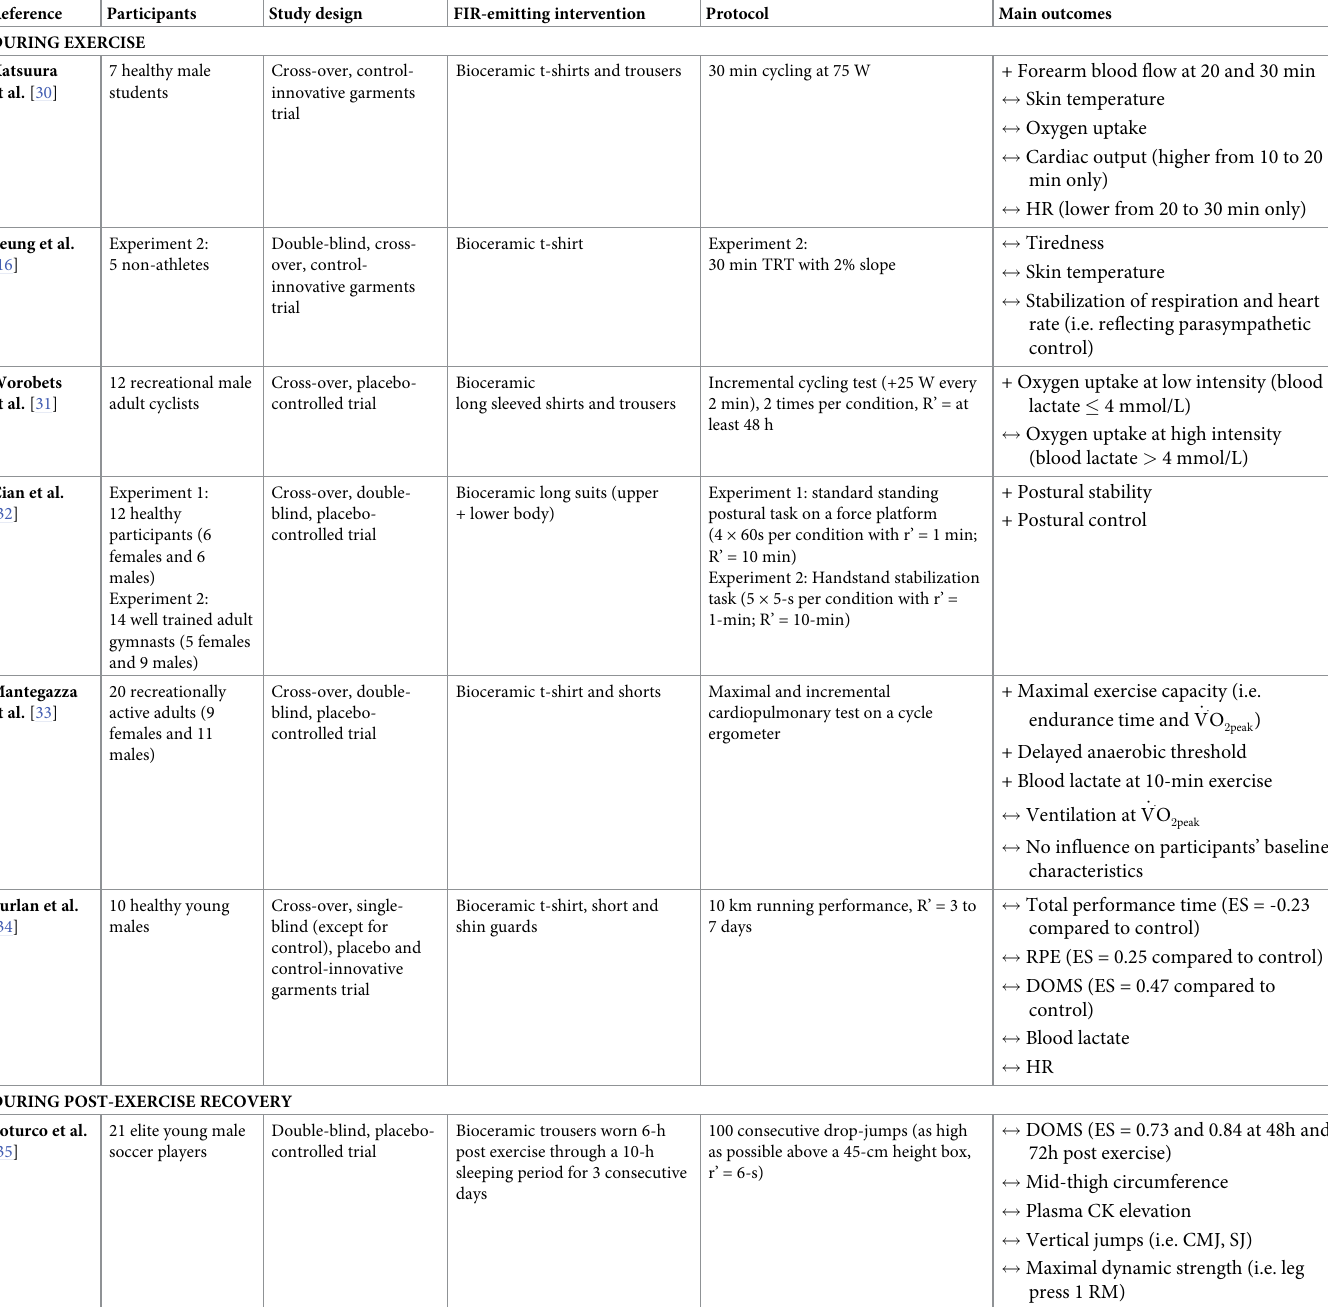
Table 1. Summary of studies included in the review examining the use of innovative FIR-emitting garments during physical exercise and during the post-exercise recovery period.